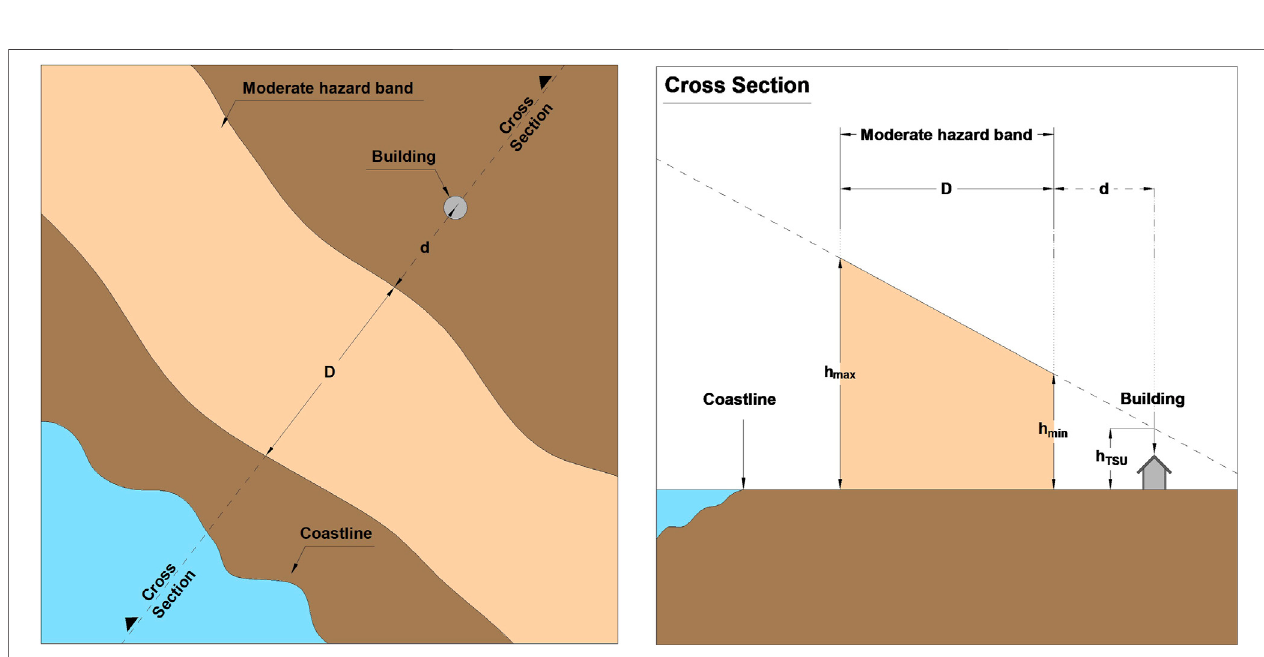
FIGURE 7 | Method for calculating the Hazard